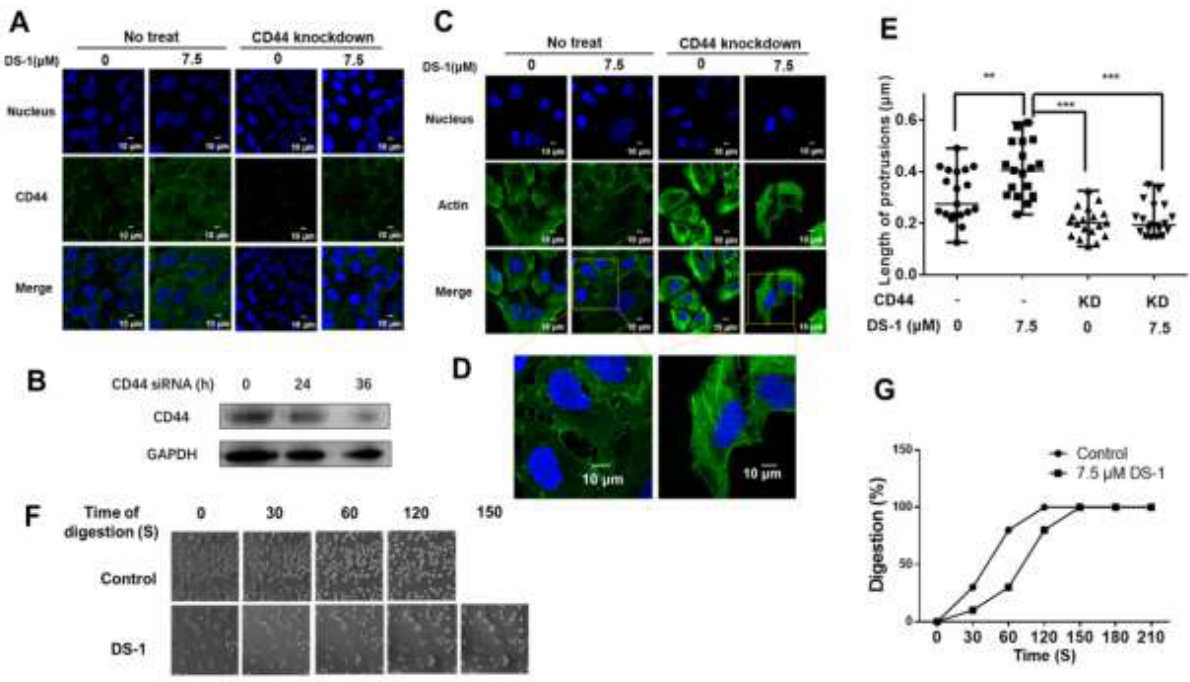
Figure 8. CD44 knockdown reduced cell adhesion by shortening cell protrusions. ( A ) U − 2 OS cells transfected with CD44 siRNA and no siRNA were seeded into a 24-well plate treated with 7.5 µ M DS − 1 for 24 h, and the expression of CD44 was detected by immunofluorescence. ( B ) CD44 expression of U − 2 OS cells was detected by Western blotting after being treated with siRNA for 0, 24, and 36 h. ( C ) U − 2 OS cells were first transfected with/without CD44 siRNA and then treated with DS − 1 for 24 h, and its actin morphologies were detected. The representative magnified actin morphologies are listed in ( D ). ( E ) The lengths of protrusions in ( C ) were analyzed by Image J and are shown in a scatterplot graph. The lengths of 20 protrusions from actin in ( C ) were calculated. Each value is the average of 20 lengths of protrusions, ** p < 0.01, *** p < 0.005. ( F ) U − 2 OS cells were transfected with CD44 siRNA, then treated with 0 and 7.5 µ M DS − 1 for 24 h and digested with trypsin at 25 ◦ C; the digestion time was recorded by a microscope, and photos were taken every 30 s. The percentage of digested cells is recorded in ( G